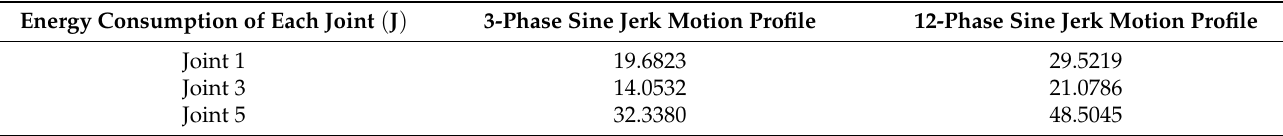
Table 7. Comparison of energy consumption of joints’ 3-phase and 12-phase sine jerk motion profile in the experiment. Energy Consumption of Each Joint ( J